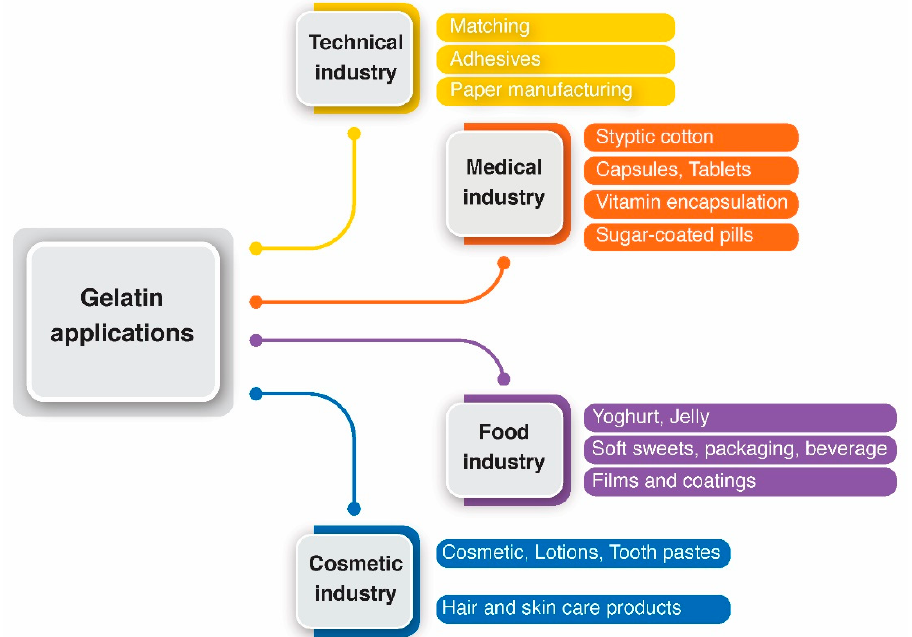
Figure 3. Gelatin applications in the industries.